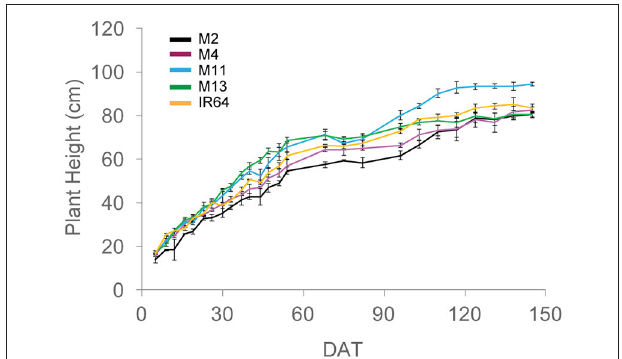
FIGURE 1 | Plant height over the course of the experiment, calculated as the average of five measurements per plot. The means of three plots are shown with standard errors of the mean. M2, M4, M11, and M13 refer to Shan-Huang Zhan-2 (SHZ-2), IR4630-22-2-5-1- 3, 157 WAB 56-125, and Inia Tacuari,